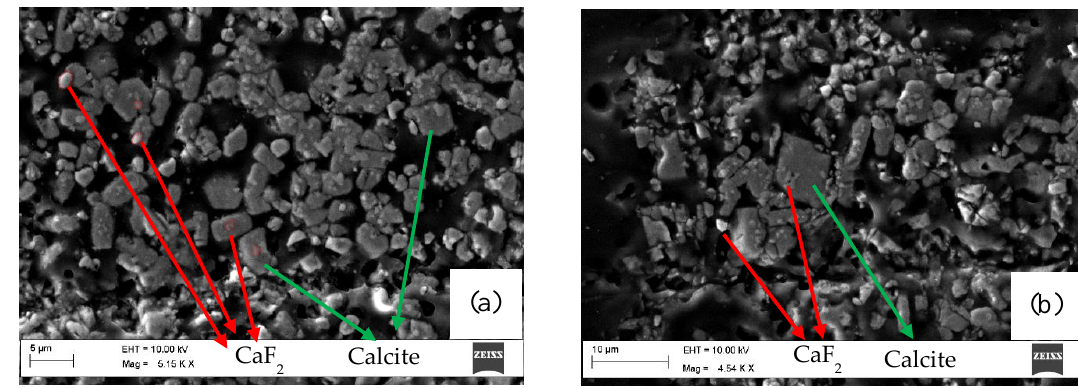
Figure 5. SEM image of residue obtained from the experiment with NaHCO 3 at 70 °C, pH 9.0. ( a , b ) shows two di ff erent regions of the same